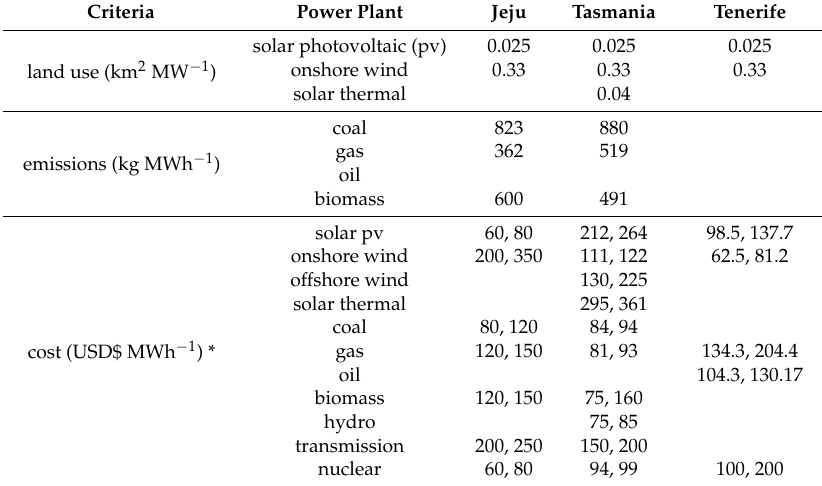
Table 2. Land-use, greenhouse-gas emissions and average generation cost of each energy-generation source for the three case-study islands: Jeju, Tasmania and